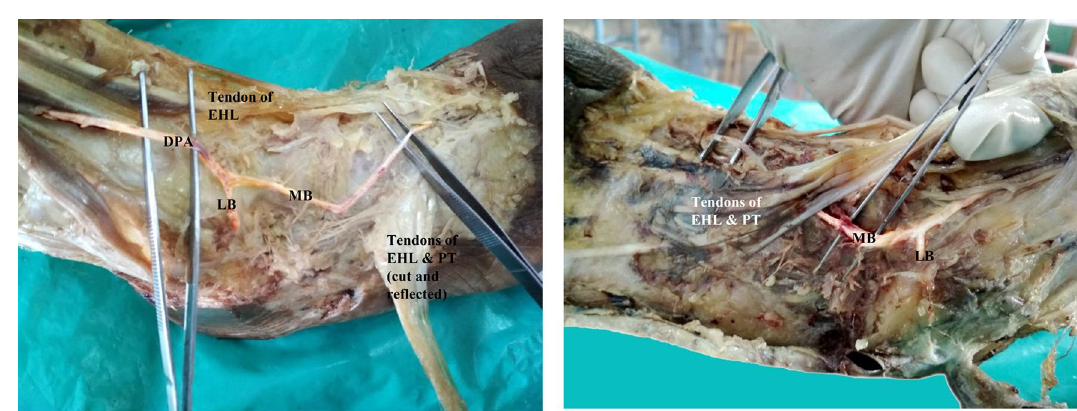
Figure 3. Showing bilateral deviation and bifurcation of dorsalis pedis artery and extremely thin dorsalis pedis artery in right limb. DPA-Dorsalis pedis artery, LB-lateral branch, MB-medial